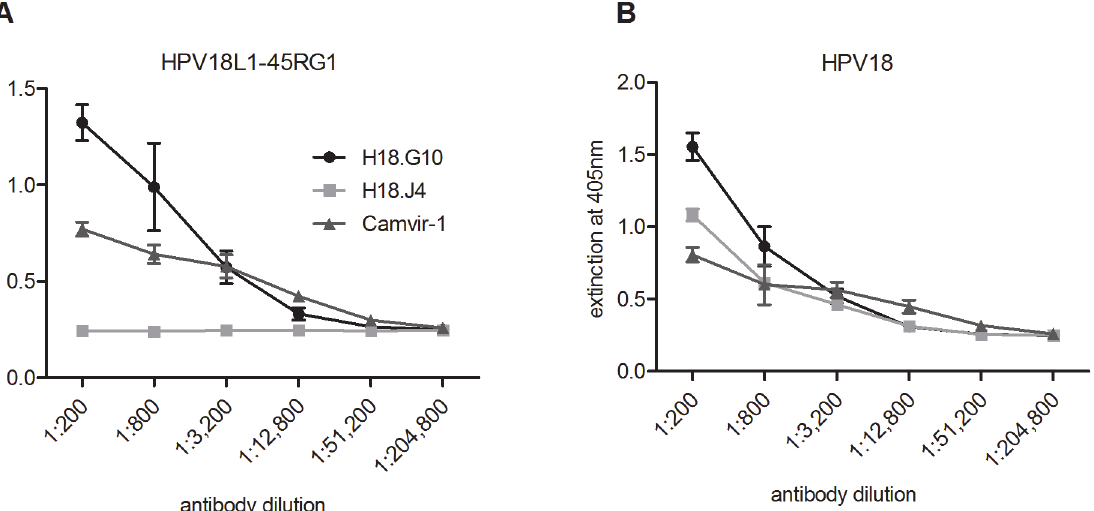
Fig 3. Characterization of chimeric HPV18L1 – 45RG1 by ELISA. Chimeric 18L1 – 45RG1 VLP (left) or wt HPV18L1 VLP (right) (50ng per well) were used as antigens and attached to 96 well plates under native conditions. ELISA was performed in triplicates with fourfold serial antibody endpoint dilutions ranging from 1:200 – 1:204,800 using HPV18-specific conformational-dependent neutralizing mAb H18.G10 and H18.J4, or non-neutralizing mAb Camvir-1 directed to a linear L1 epitope. Results indicate that RG1 epitope insertion into HPV18L1 – 45RG1 VLP disrupted (or sterically hindered) the recognition site of H18.J4, whereas the sites for H18.G10 and Camvir-1 remained intact. Data are shown as mean OD ± standard deviation (SD).